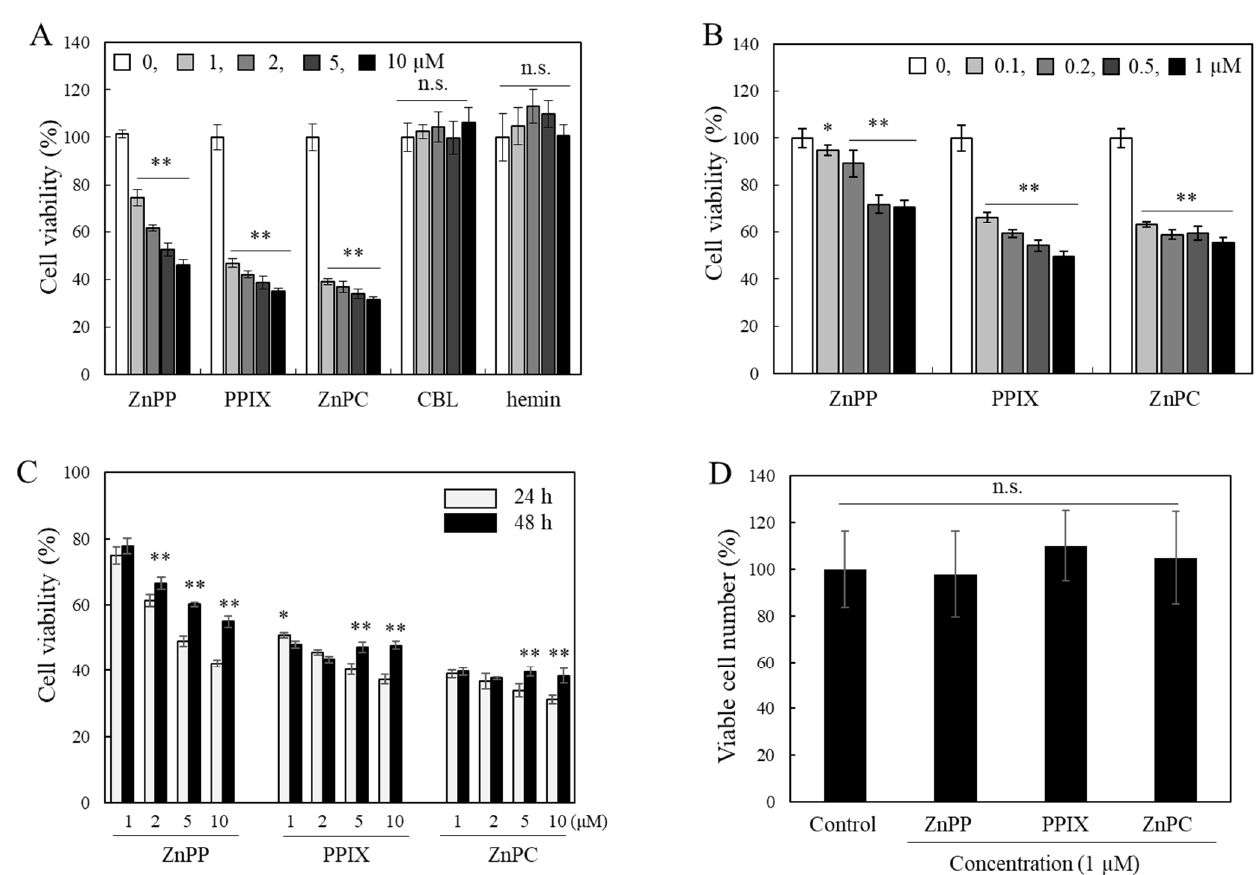
Figure 1. Effects of different porphyrin ‐ related compounds on cell viability analyzed using the MTT assay. INT407 cells were treated with different concentrations of porphyrin ‐ related compounds (0–10 μ M) ( A ) or sub ‐ micromolar levels (0–1 μ M) ( B ) for 24 h, and cell viability was analyzed using the MTT assay. Effects of 3 porphyrin derivatives after 24 and 48 h treatment were compared ( C ). Numbers of viable cells using the trypan blue assay were also analyzed ( D ). Each value represents the mean ± S.D. ( n = 8). *, ** Significantly different from control or between 24 and 48 h (in ( C )) according to Student’s t ‐ test (*, p < 0.05; **, p < 0.01). n.s., not significant.